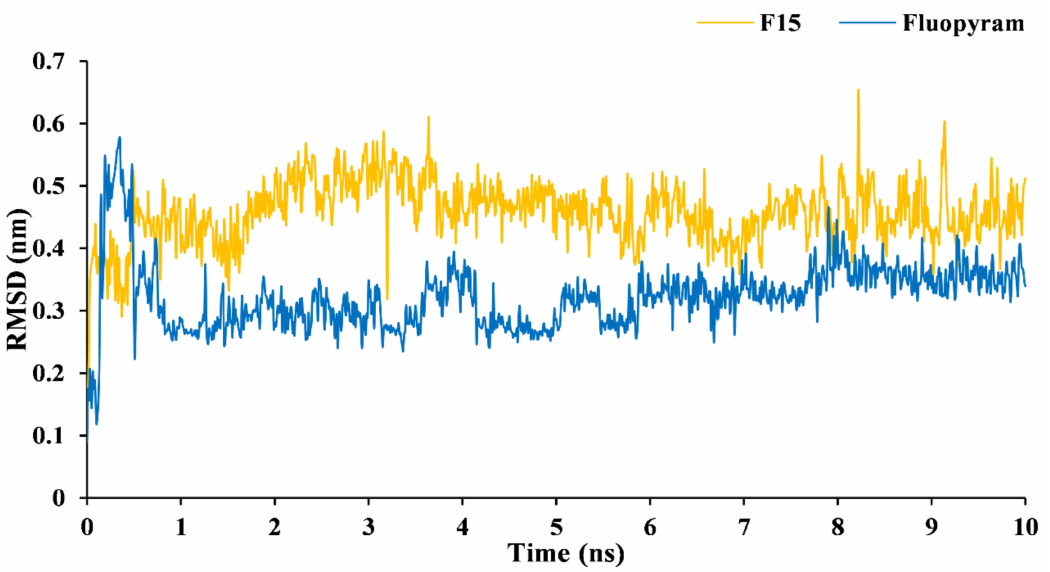
Figure 7. Plots of the RMSDs of SDH with compound F15 and fluopyram during the 10 ns